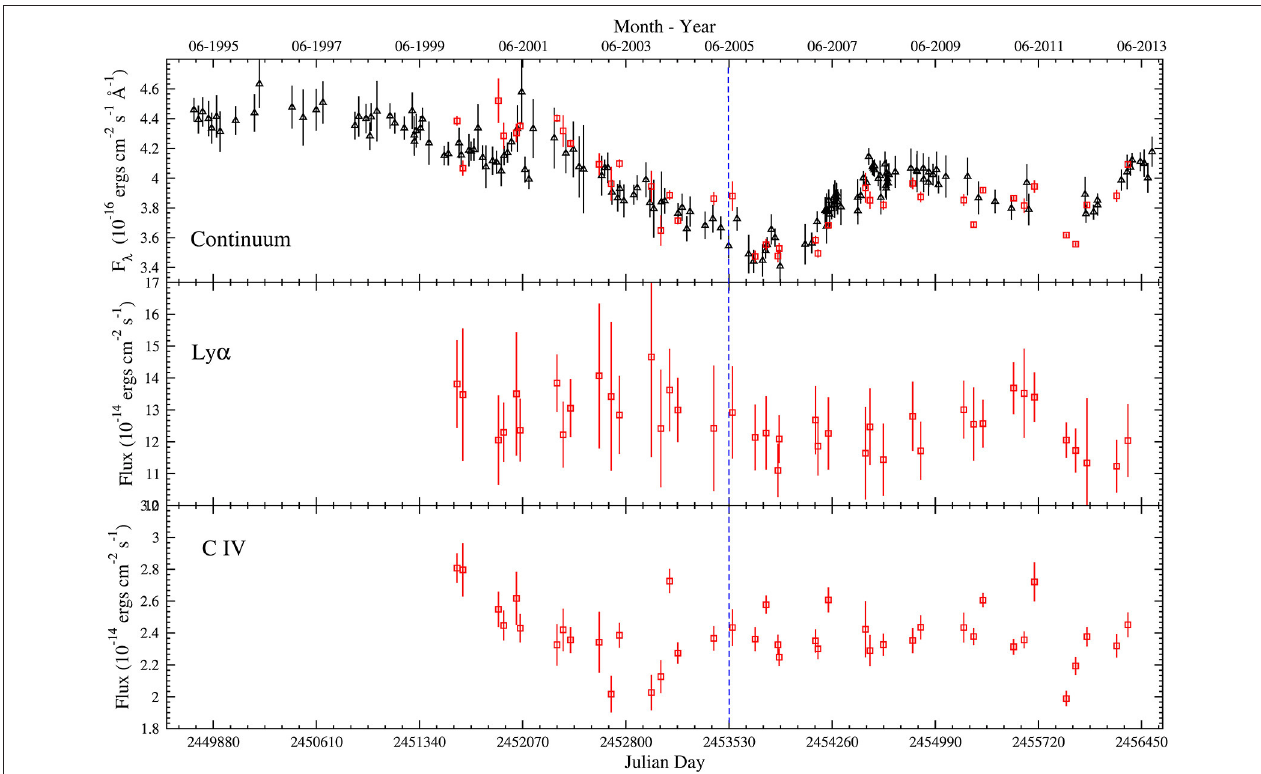
FIGURE 2 | Light curves for SBS1233 + 594. Red squares are points measured from the spectroscopic data and black triangles are points measured from the photometric data. The top panel is the continuum light curve (spectroscopic points measured on the red side of the C IV line). The middle panel and lower panel are line light curves for Ly α and C IV , respectively. Data up to the blue vertical dashed line were published in Kaspi et al. (2007).